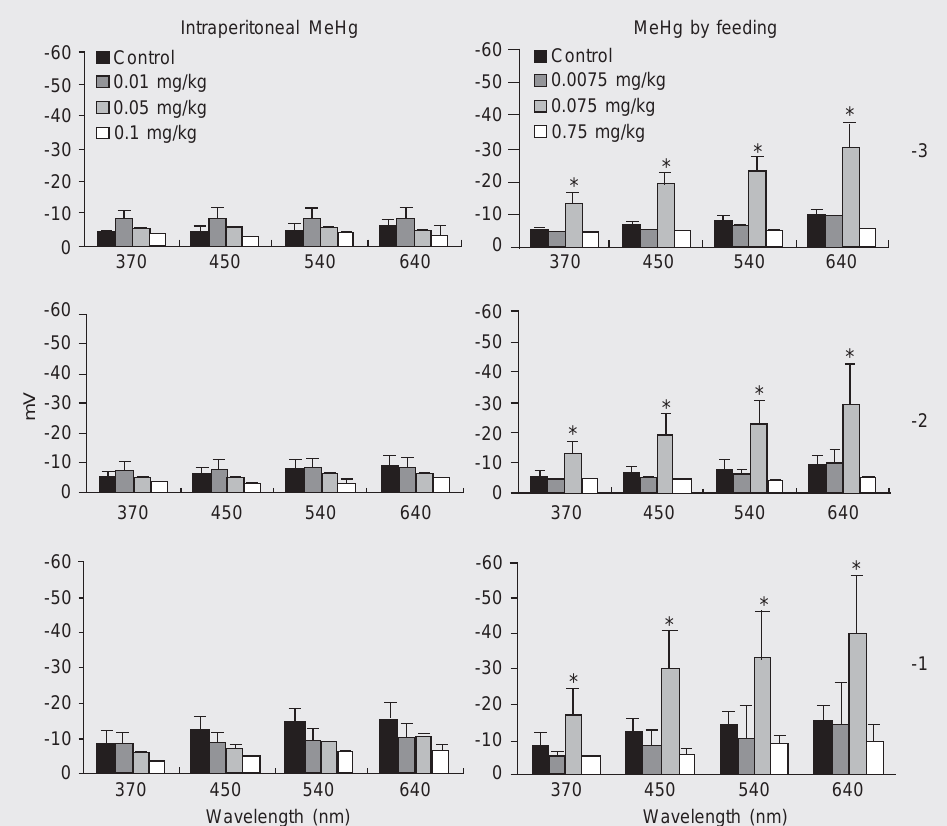
Figure 2. Response amplitudes of the retinal horizontal cells at four different wavelengths (ab- scissa) and three light intensi- ties (indicated by the attenua- tion log values from the original at the right of the graphs). The bars represent the mean ± SD. A statistically significant differ- ence was observed between the control group and the group intoxicated with 0.075 mg/kg through feeding. For all groups there was a similar pattern of the decrease in amplitude de- crease with the increase of the log attenuation indicated by the numbers on the right side of the